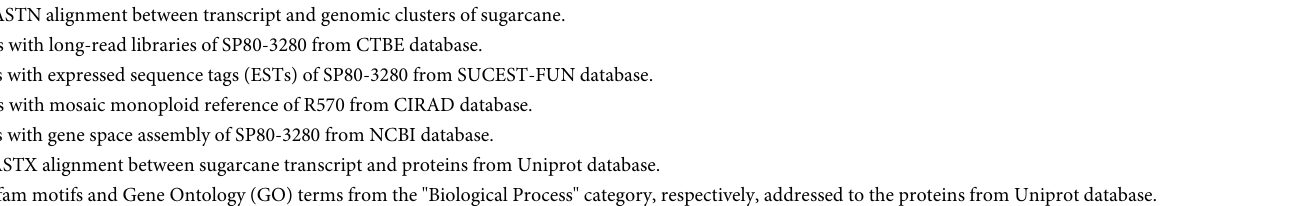
oxidoreductases have been shown to be activated in Arabidopsis thaliana in response to turnip mosaic virus infection by a genome-wide association study [80]. Alignment with SYT proteins and the GO term “lipid transport” was observed for DTF 5000_34, which was downregulated according to cDNA-AFLP observations. The SYTA protein is the best studied among A . thali- ana SYT proteins, which play a role in the response to abiotic and biotic stresses [81].